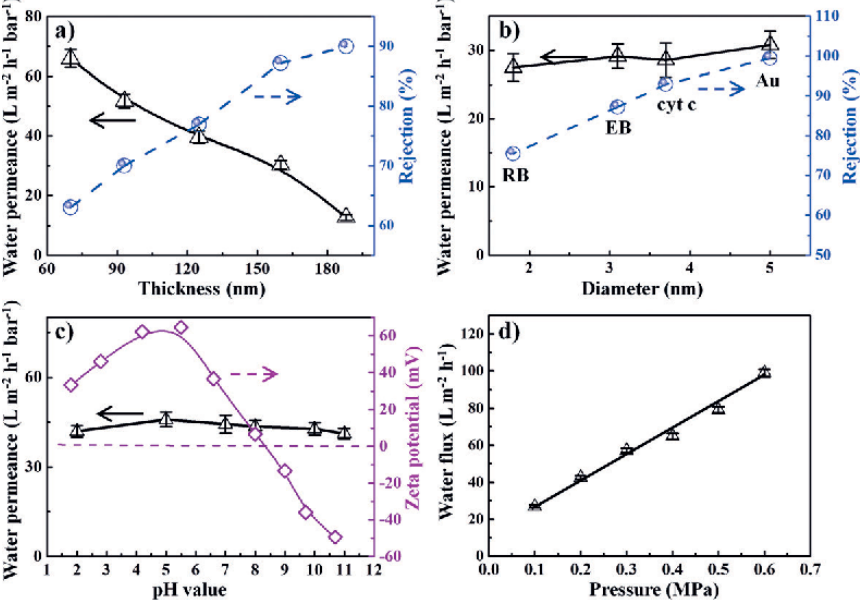
Figure 3. MXene-based (g-C 3 N 4 ) nanosheet membranes for dye separation: g-C 3 N 4 nanosheet mem- branes; separation performance of g-C 3 N 4 membranes against different dye molecules. ( a ) Separation performance based on the thickness of the membranes; ( b ) against the diameter (size) of each probe molecule; ( c ) water permeance and zeta potential of the membrane in different pH environ- ments; ( d ) water permeability based on variable pressure. Reprinted with permission from [87]. Copyright 2020 American Chemical Society.